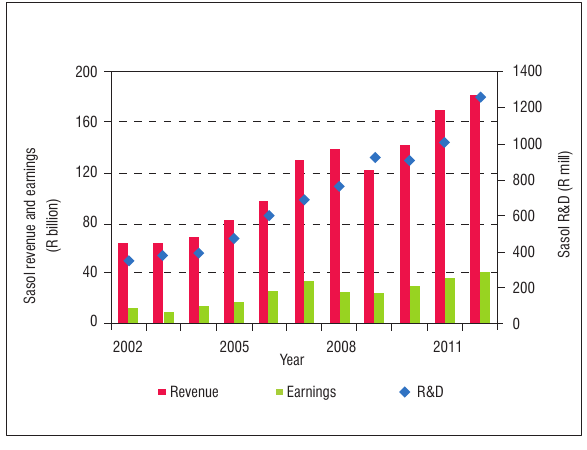
Figure 8: Sasol’s revenue, earnings and R&D expenditure (2002 to